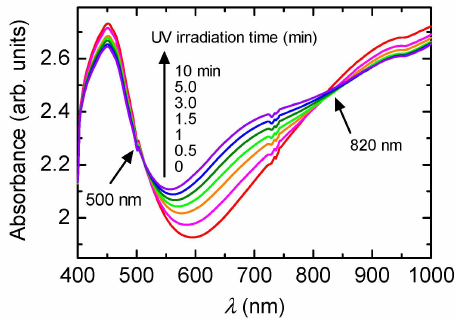
Figure 1. UV-vis absorption spectra of PANI/( ´ )-CSA under UV light